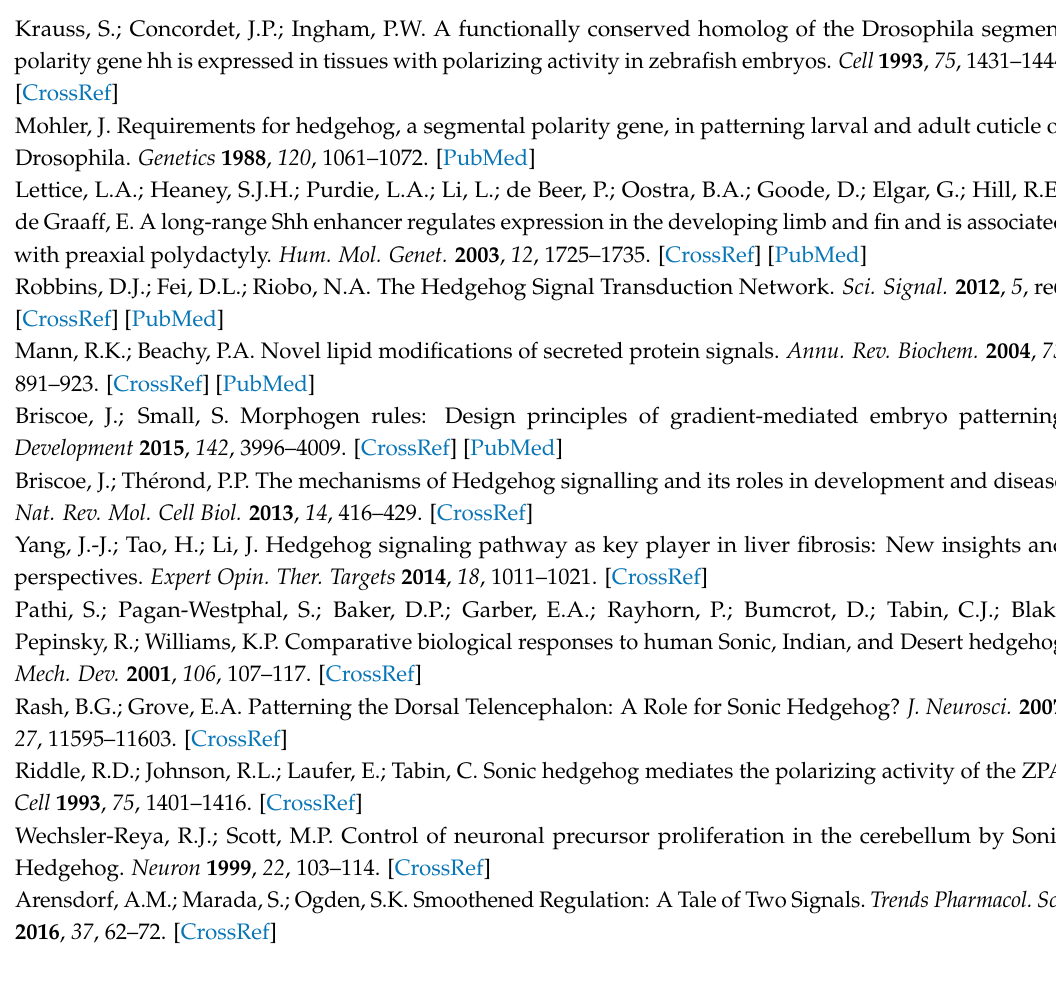
Table S1: Genetic and epigenetic modifications of Gli genes in human cancer. Funding: This research was funded by Narodowe Centrum Nauki grants SONATA BIS 2014/14/E/NZ3/00033, FUGA 2016/20/S/NZ3/00213, and PRELUDIUM 2018/29/N/NZ3/01523. Conflicts of Interest: The authors declare no conflicts of